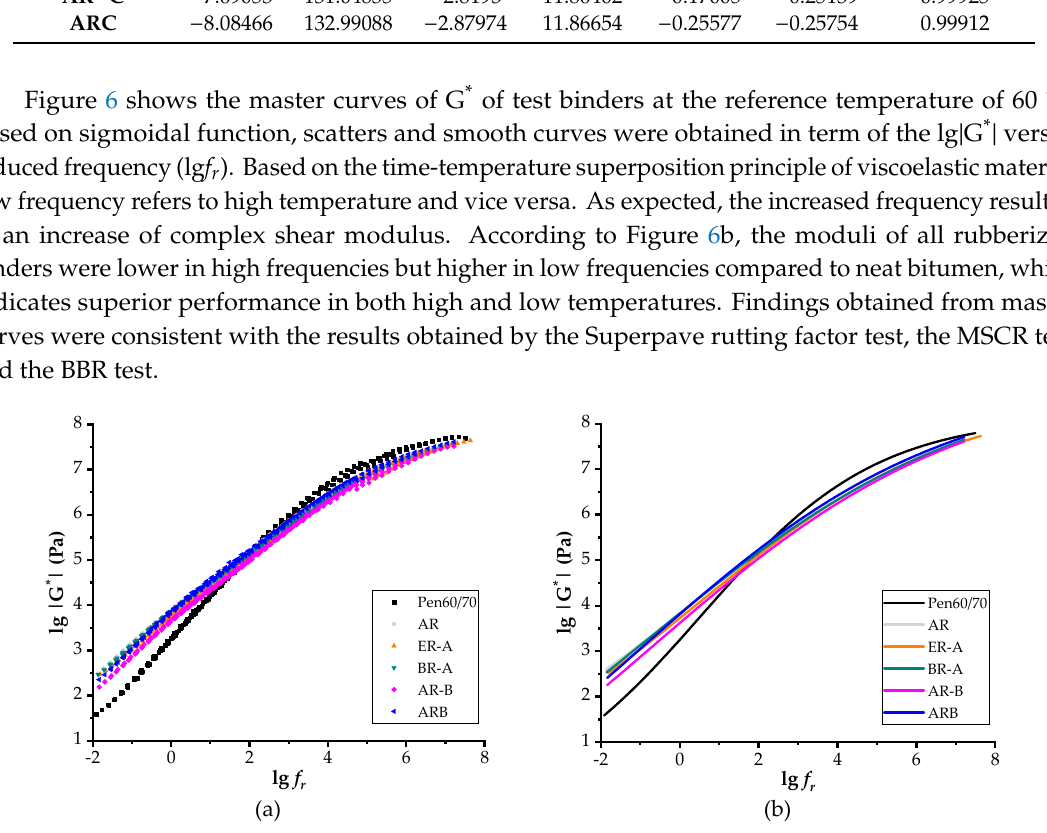
Figure 6. Master curves of test binders: ( a ) scatters of test results and ( b ) sigmoidal fitting curves.